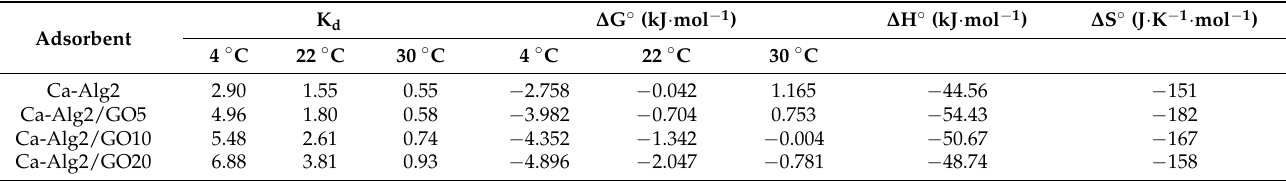
Table 3. Thermodynamic parameters for DFC adsorption on Ca-Alg2, Ca-Alg2/GO5, Ca-Alg2/GO10 and Ca-Alg2/GO20 beads. Adsorbent